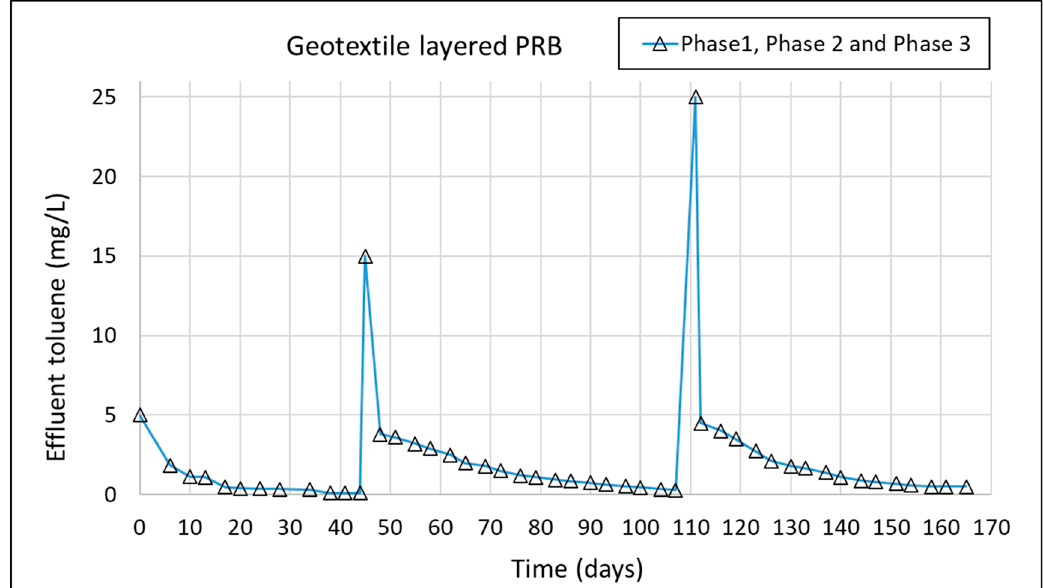
Figure 5. Changes in toluene concentrations in the PRB-2 column for phase 1, phase 2, and phase 3 combined.